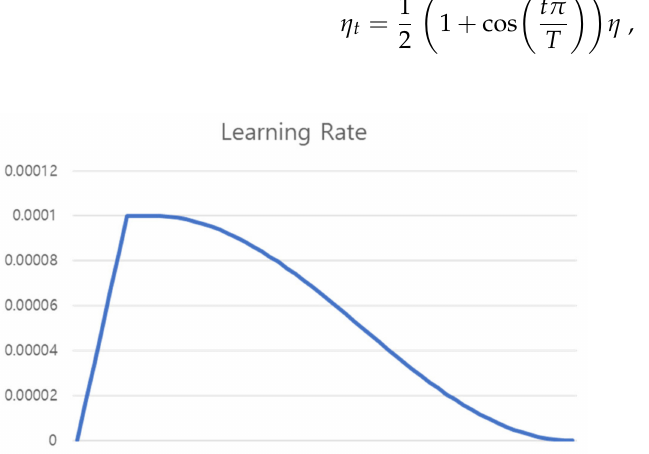
Figure 12. Learning Rate